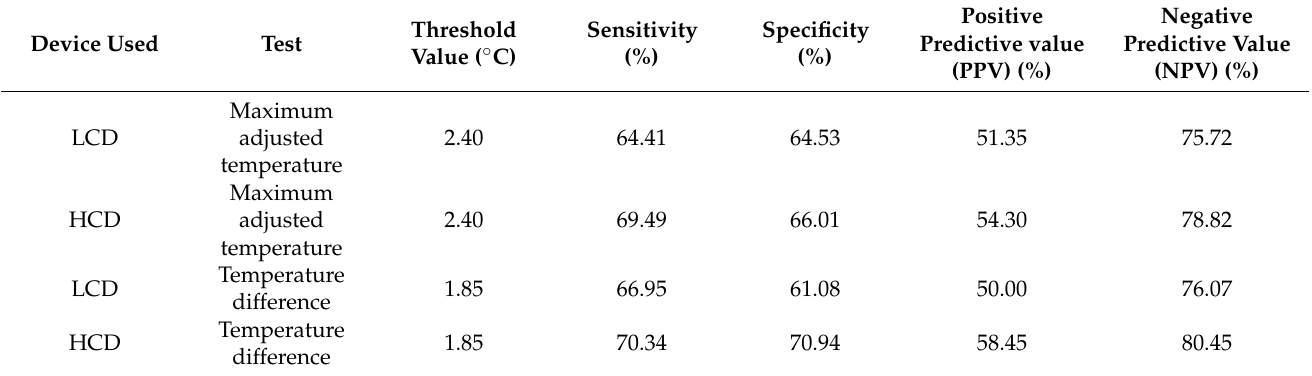
Figure 10. ( a ) An ROC curve showing the sensitivity and specificity of different threshold values in determining whether a cow is lame based on the data collected of the difference between the hind foot temperatures, calculated from the residuals from the average healthy foot temperature on each data collection day collected by the CAT s62-Pro Smartphone (LCD). ( b ) An ROC curve showing the sensitivity and specificity of different threshold values in determining whether a cow is lame based on the data collected of the difference between the hind foot temperatures, calculated from